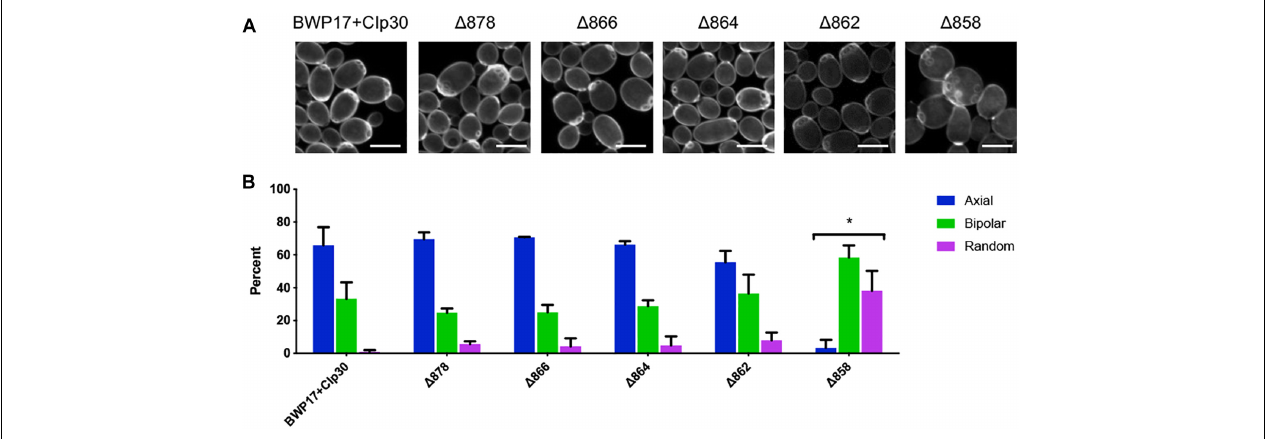
FIGURE 8 | Pma1p truncation affects bud scar distribution. (A) Pma1p truncation mutants were stained with the chitin-binding dye Calcofluor white. Cells were imaged using a confocal microscope. A Z-stack comprised of 0.2-micron thick slices is shown. Scale bars indicate 5 µ m. (B) Bud scar distribution was scored as axial, bipolar or random. These experiments were completed twice; both replicate experiments are represented here. Pma1p truncation significantly increases bipolar or random budding. Strains were analyzed for statistical differences compared to budding patterns of the BWP17+CIp30 control via two-way ANOVA followed by a multiple comparison post-test. Asterisks denote statistical significance ( p > 0.01).